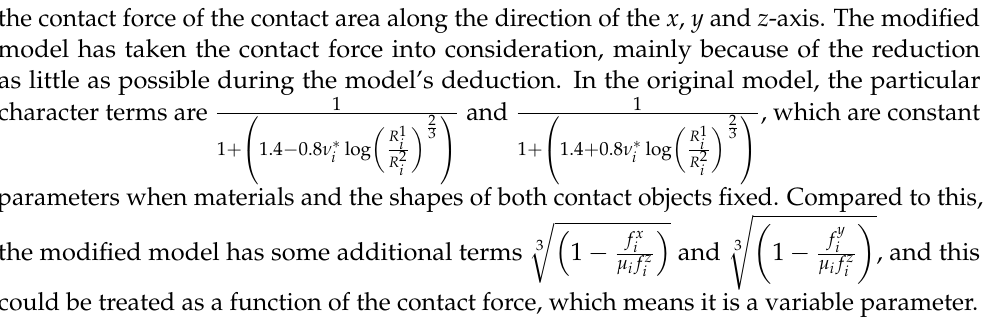
Table 5. The comparison between the original model and the modified model. Modified